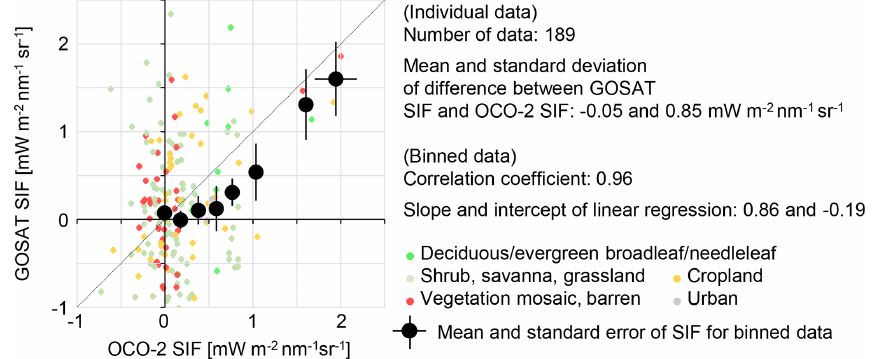
Figure 4. Scatter plot of GOSAT SIF and OCO-2 SIF, whose footprints were included in the GOSAT TANSO-FTS footprint. Individ- ual GOSAT data are depicted by small circles with colours representing the land cover type. OCO-2 SIF values between − 0 . 1 and 2.1mWm − 2 nm − 1 sr − 1 were binned with an interval of 0.2mWm − 2 nm − 1 sr − 1 , and the mean and standard error of GOSAT SIF and OCO-2 SIF were calculated for each